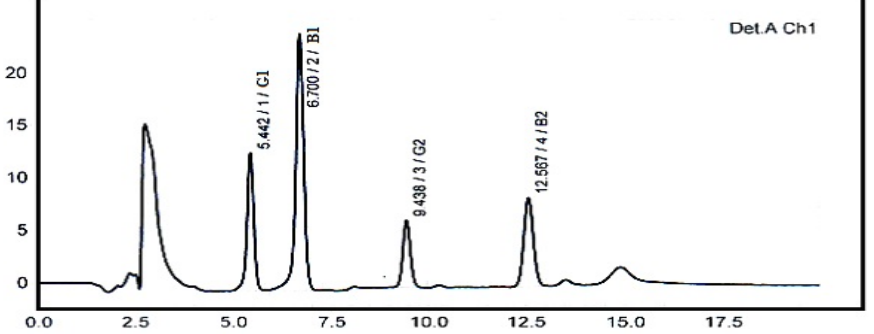
Figure 1. High Performance Liquid Chromatography (HPLC) Chromatogram of 5 ppb standard mixture of four aflatoxins.